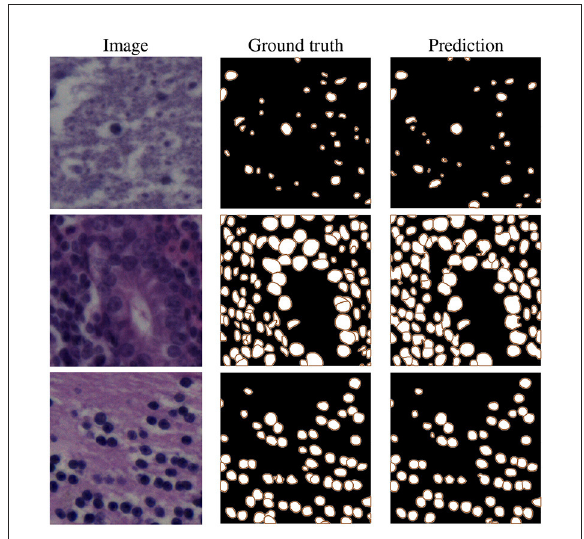
FIGURE6 Example results on NuInsSeg test images, selected from human brain (top) , human cardia (middle) , and human cerebellum (bottom) samples.